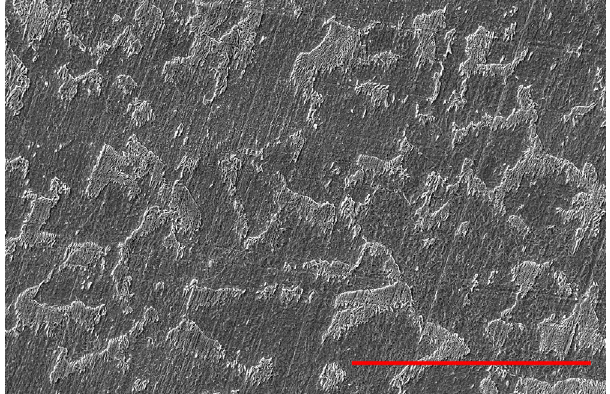
Fig. 5. SEM image of the hypoeutectoid steel: dark gray, ferrite; light gray, pearlite. The red line represents 40 m